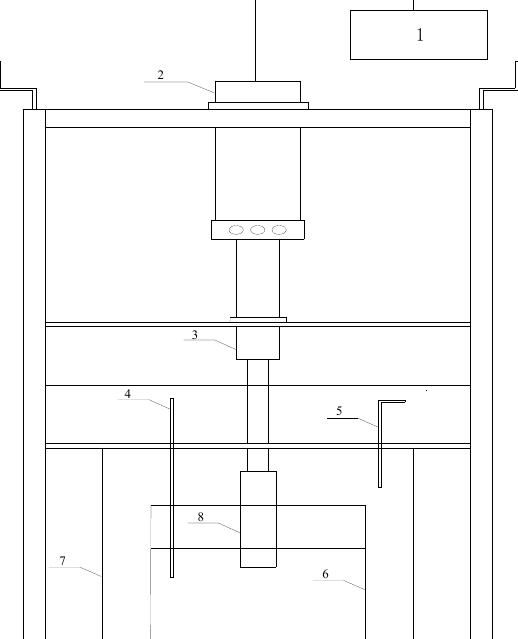
Figure 1. Schematic illustration of the experimental set-up: 1 Ultrasonic generator, 2 Transducer, 3 Horn, 4 SF 6 + CO 2 , 5 Thermocouple, 6 Stainless steel crucible, 7 Resistance furnace, 8 Tool head. Mg-3Y-3.5Sm-2Zn-0.6Zr alloy was used in this study. The raw materials included pure Mg (99.99 wt %) ingot, Mg–Zr master alloy (with 30 wt % Zr), Mg–Y master alloy (with 30 wt % Y), Mg–Sm master alloy (with 20 wt % Sm) and pure Zn (99.99 wt %) ingot. The melting process of the